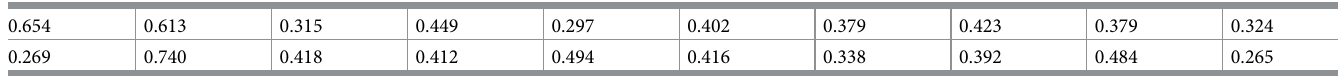
Table 1. The maximum flood level (in million of feet 3 /second) for the Susquehanna River at Harrisburg, Pennsylvania. 0.654